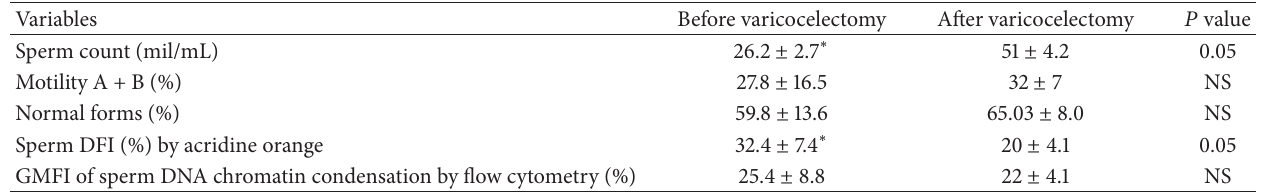
Table 2: Pre- and postvaricocelectomy semen parameters, sperm DFI, and GMFI of sperm DNA chromatin condensation by flow cytometry. Variables